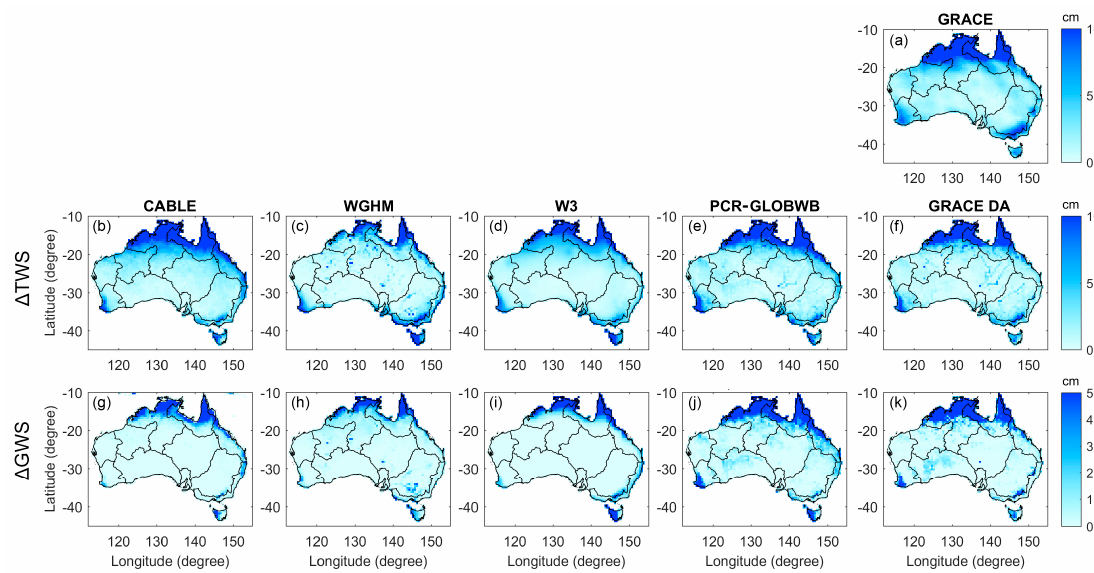
Figure 5. The seasonal amplitude (cm) of the Δ TWS (second row) and Δ GWS (third row) estimates from four models (CABLE ( b , g ), WGHM ( c , h ), W3 ( d , i ), PCR-GLOBWB ( e , j )) and GRACE DA ( f , k ) in Australia. The amplitude of the GRACE observation is also shown ( a ).